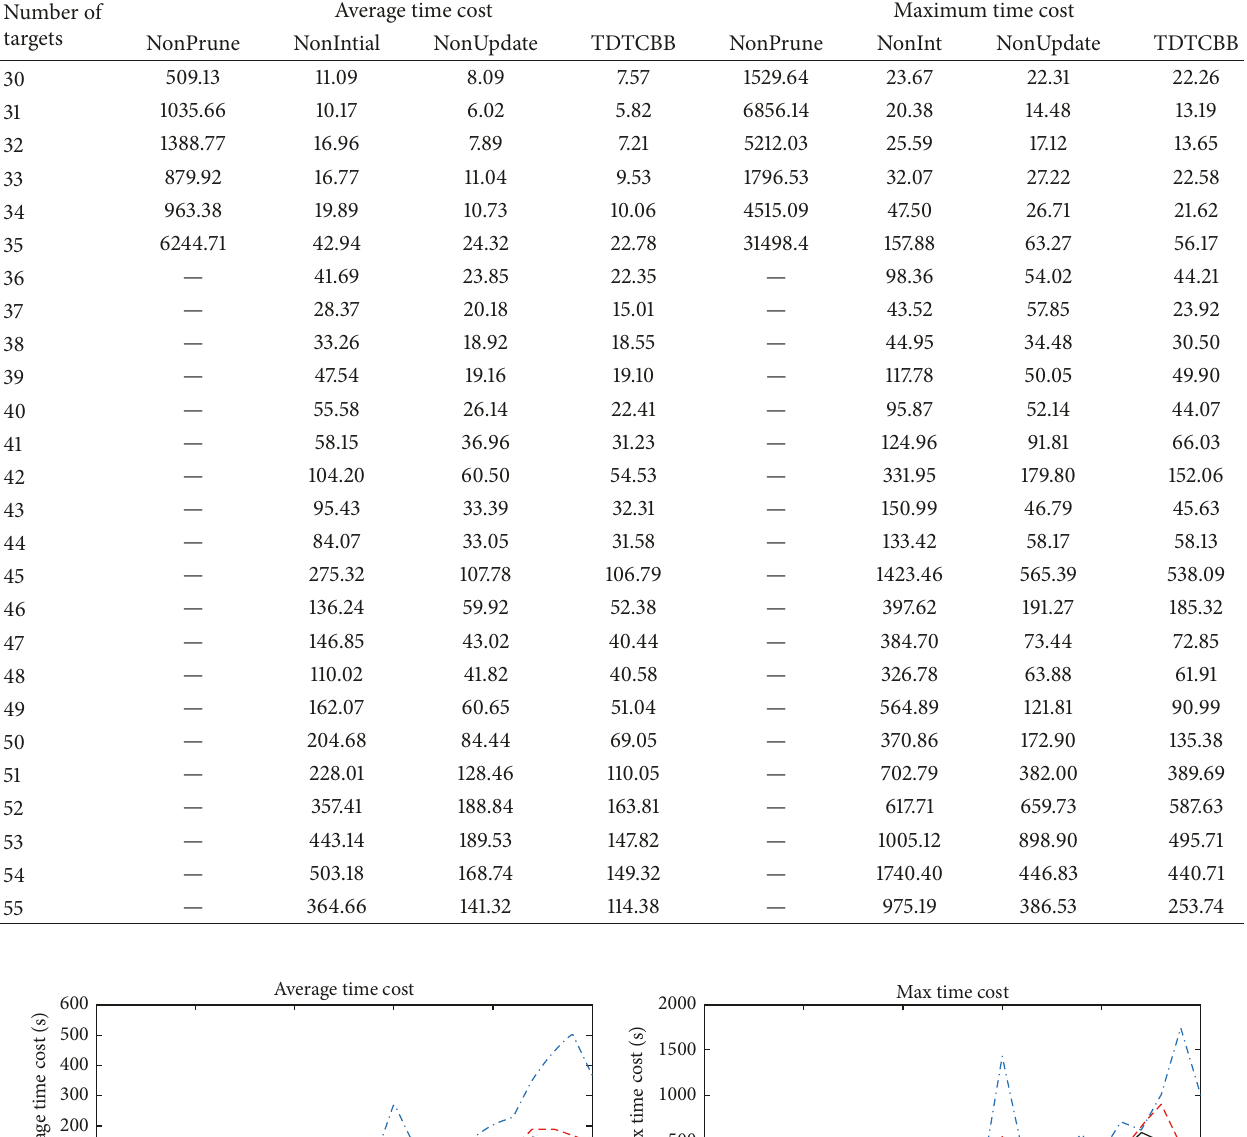
Table 2: The time costs of different algorithms.